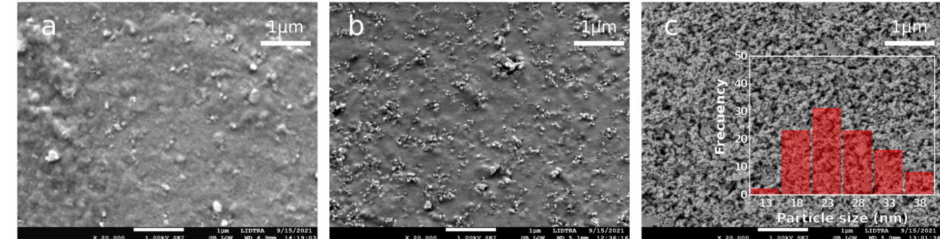
Figure 1. SEM images of CS–TiO 2 nanocomposites films with ( a ) 10 wt.% of TiO 2 NPs, ( b ) 30 wt.% of TiO 2 NPs and ( c ) 50 wt.% of TiO 2 NPs. Insert on Figure 1c shows NPs distribution.